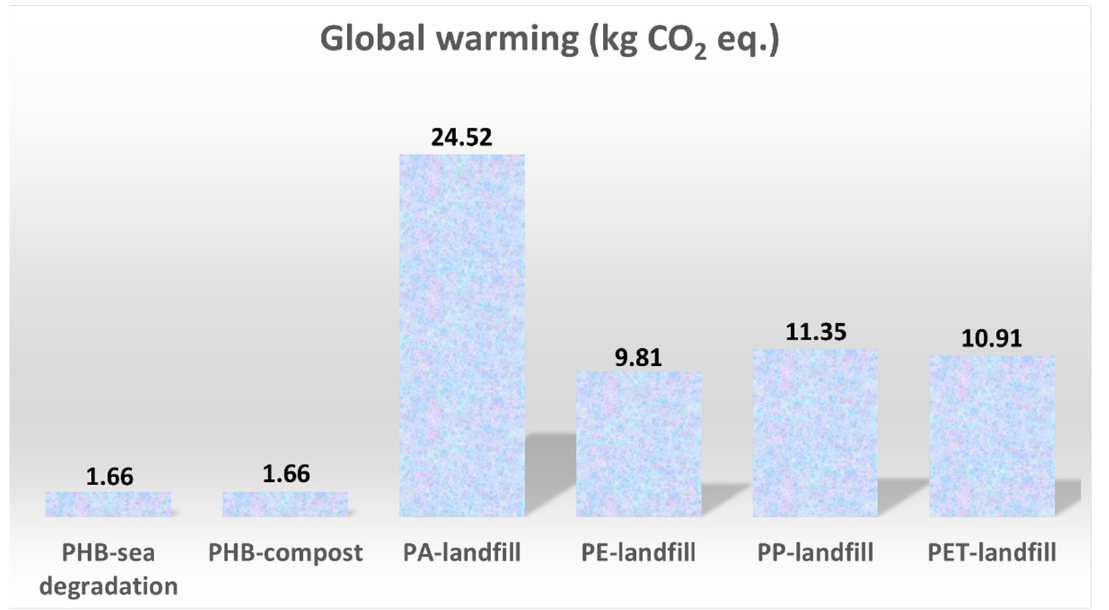
Figure 13. Global warming category for the studied cases “a”, “b” and “c”.